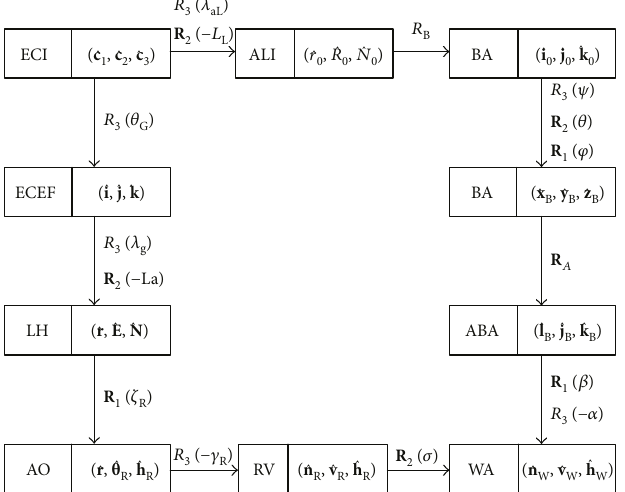
Figure 6: Reference frames and related rotation matrices.